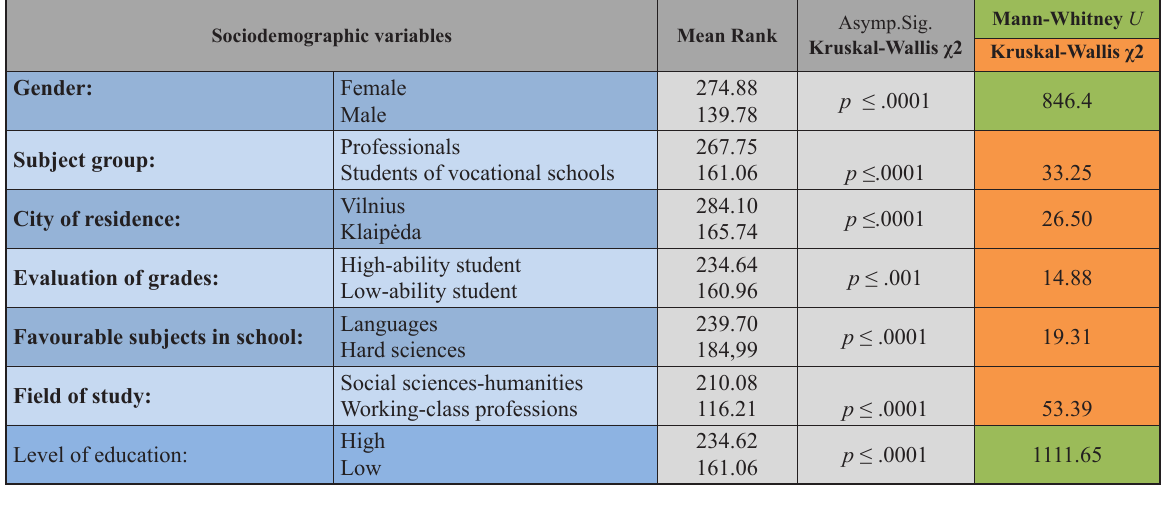
Figure. Comparison of empathy between males